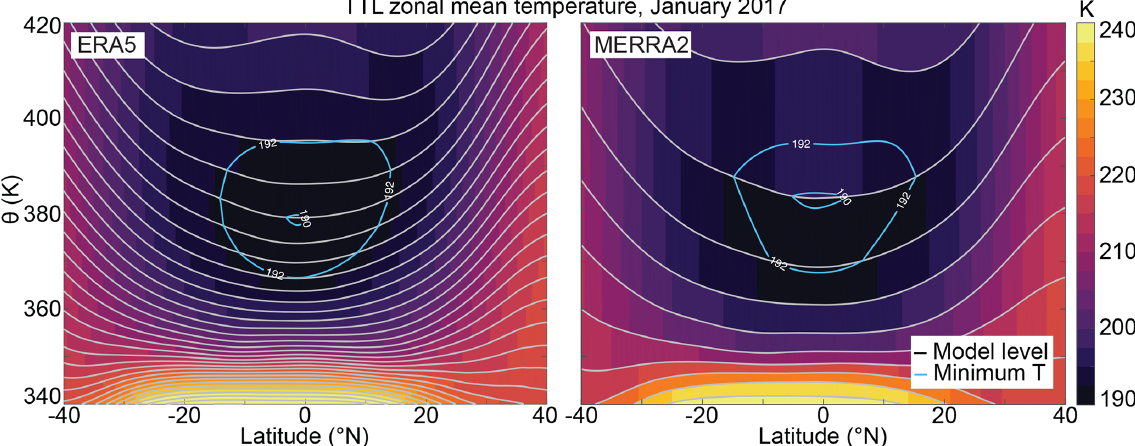
Figure 1. The January 2017 zonal mean tropical tropopause temperature for ERA5 and MERRA2 reanalysis data. Note the increased number of model layers near the coldest temperatures for the ERA5 data. A plot of the reduced resolution ERA5 data used in this paper is shown in Fig.